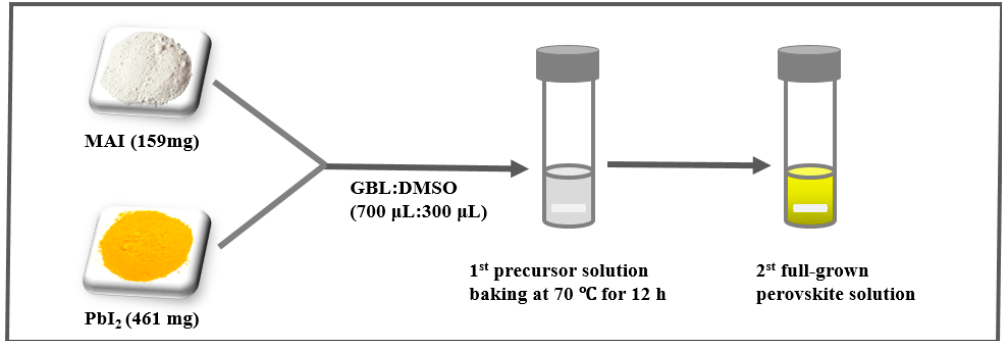
Figure 2. Solvent engineering procedure for the preparation of the perovskite precursor solution.